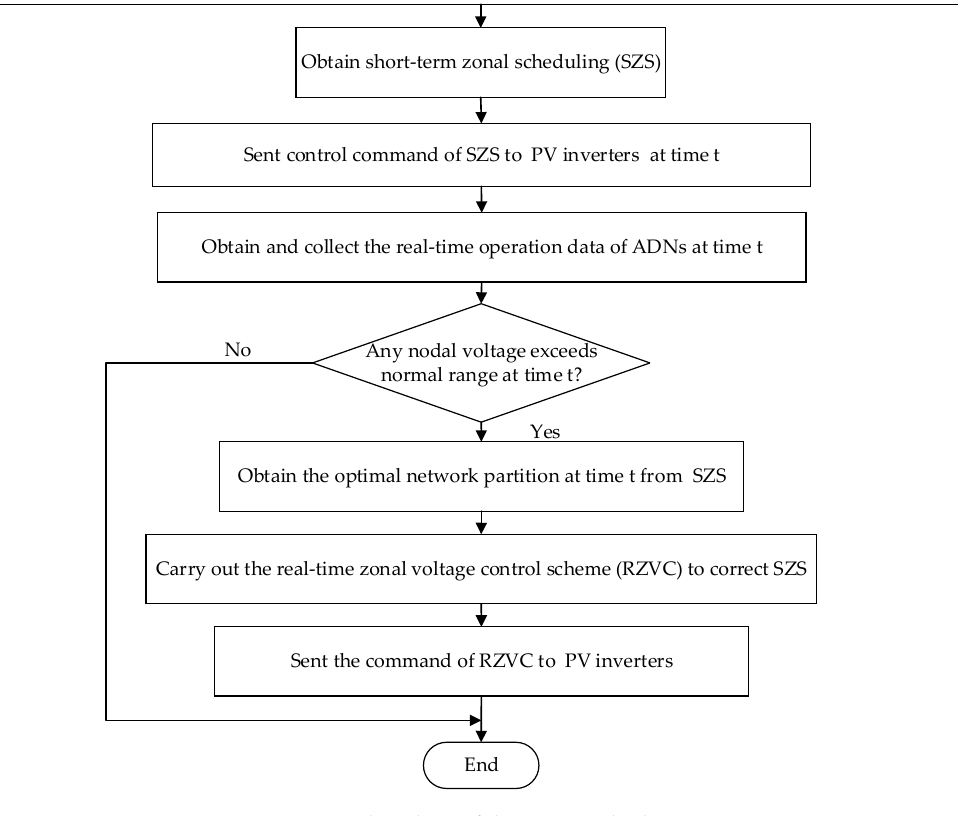
Figure 1. Flowchart of the proposed scheme.